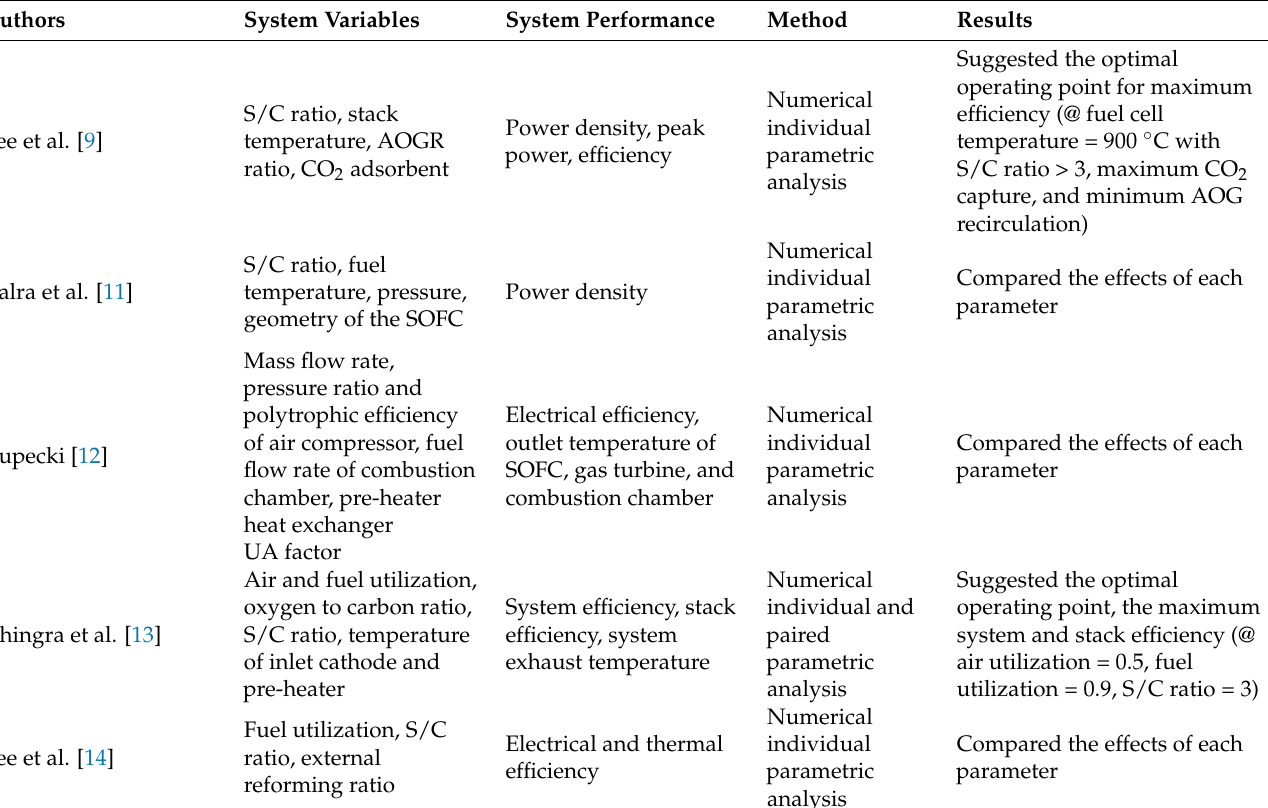
Table 2. A literature summary of the SOFC analysis for design and